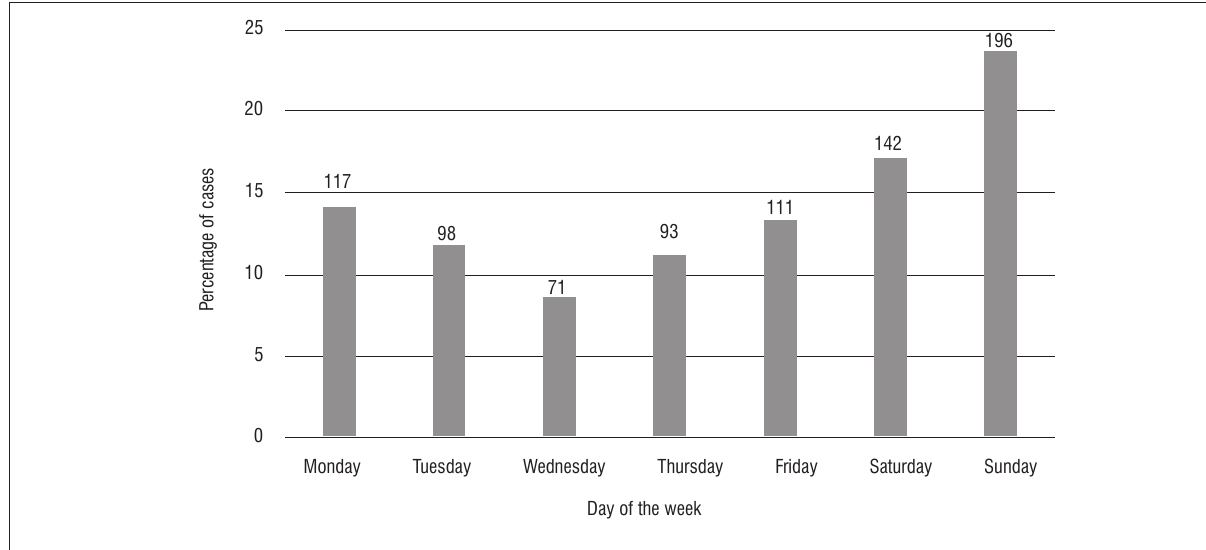
Figure 3: Percentage distribution of blunt force homicide cases from 2010 to 2014 across the days of the week.